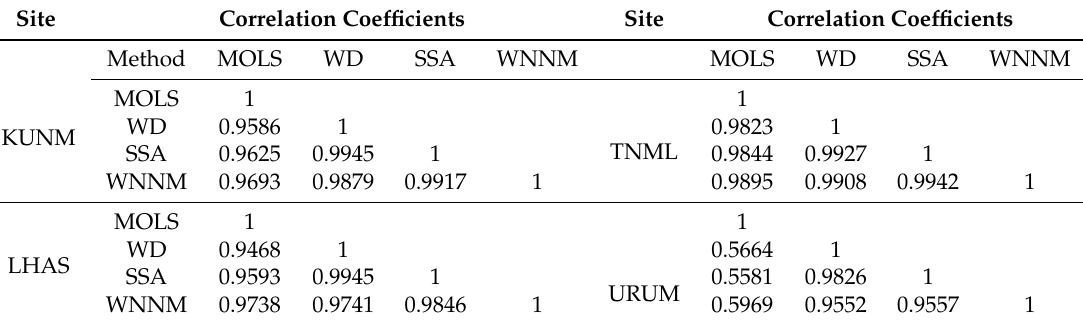
Table 10. Correlation coefficients of extracting signals for the Up component of the other eight stations under different